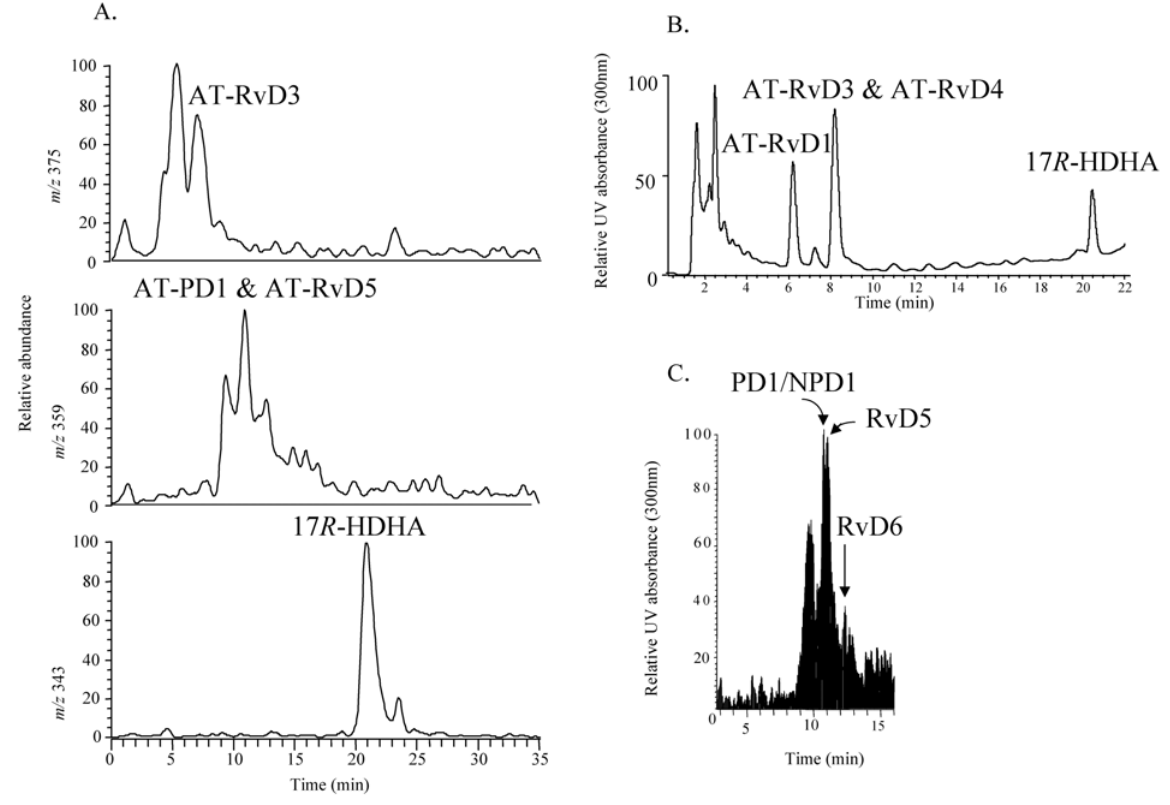
FIGURE 3. Chromatograms of biogenic resolvins, AT-Rv, and protectin D1. (A and B) AT inflammatory exudates produce 17 R -containing AT-Rvs. Exudates were obtained and analyzed by procedures essentially identical to those described in Murphy et al.[6]. Selective ion chromatograms were at m/z 375 (top), 359 (middle), and 343 (bottom). The UV chromatogram was plotted at 300 nm to mark tetraene- containing chromatophores. (C) Selected ion chromatogram (m/z = 359) shows 17 S series resolvins and protectins produced in human neutrophils (30–50 × 10 6 cells/incubation), which were exposed to zymosan A and 17 S -H(p)DHA, and products were analyzed using LC- UV-MS/MS (n =